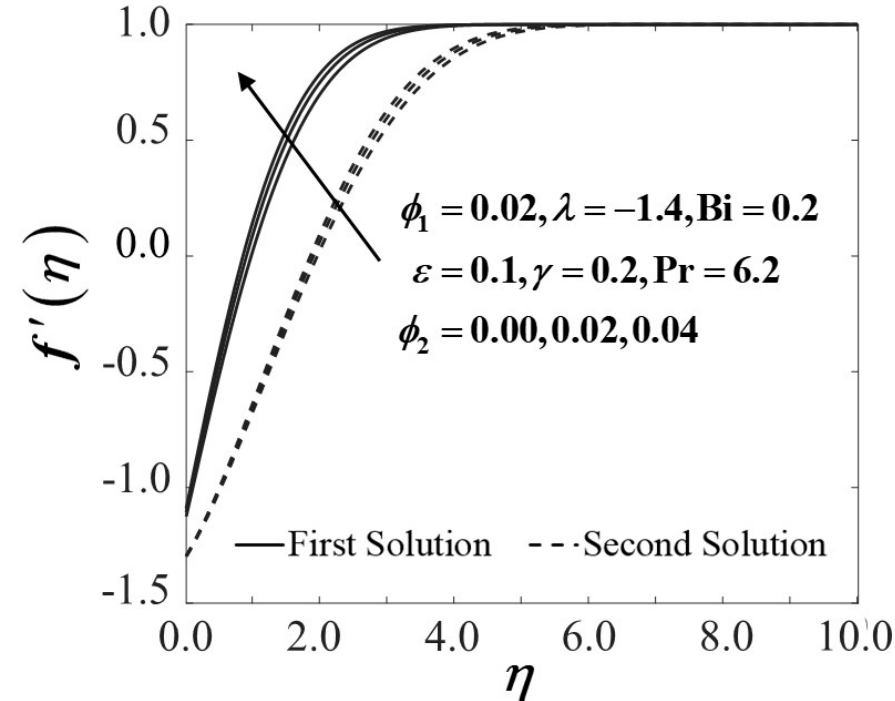
( ) f η′ Figure 8. Velocity profiles of with 1.4 λ = − (shrinking case). Figure 8. Velocity profiles of f (cid:48) ( η ) with λ = − 1.4 (shrinking case). Mathematics 2020 , 8 , x FOR PEER REVIEW 13 of 23